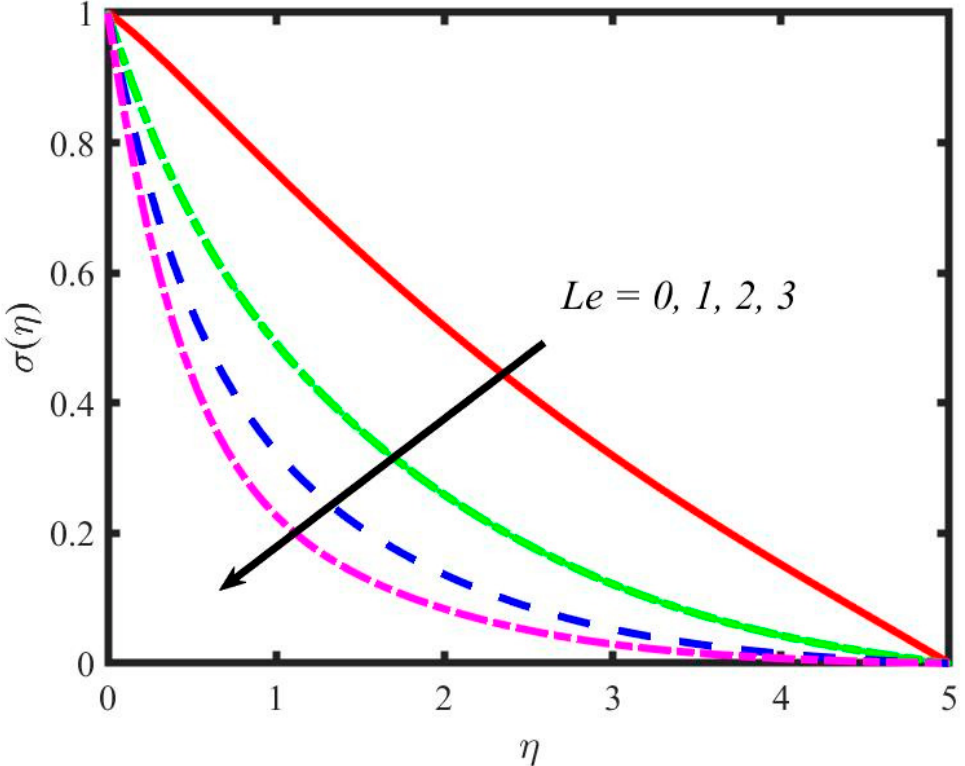
Figure 19. Variations in nanoparticle concentration for Lewis number.